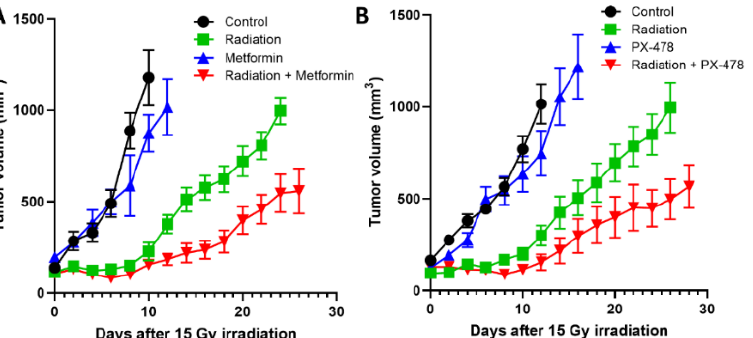
Figure 5. ( A ). Effects of irradiation (15 Gy) and metformin (150 mg/kg/day) alone and combined on the growth of FSaII tumors. ( B ). Effects of irradiation (15 Gy) and PX-478 (35 mg/kg, on days 0, 3, 18, 21) alone and combined on the growth of FSaII tumors. FSaII tumor cells (1 × 10 5 ) were subcutaneously injected into the hind legs of C3H mice. When the tumors grew to 0.5–0.7 cm in diameters, they were irradiated with 15 Gy in a single dose using 250 Kv X-rays while the animal were lightly anesthetized with an i.p injection of a mixture of 100 mg/kg ketamine and 10 mg/kg xylazine. Tumor diameters were measured using calipers. The data represent the mean volume of 5–10 tumors ± SE. PX-478 (s-2-amino-3-[4′-N, N, -bis (chloroethyl) amino] phenyl propionic acid N-